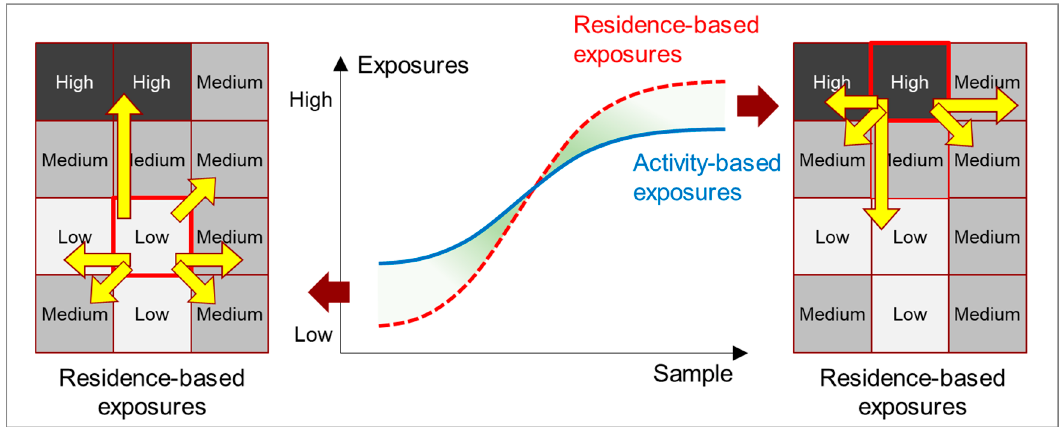
ff ect averaging problem